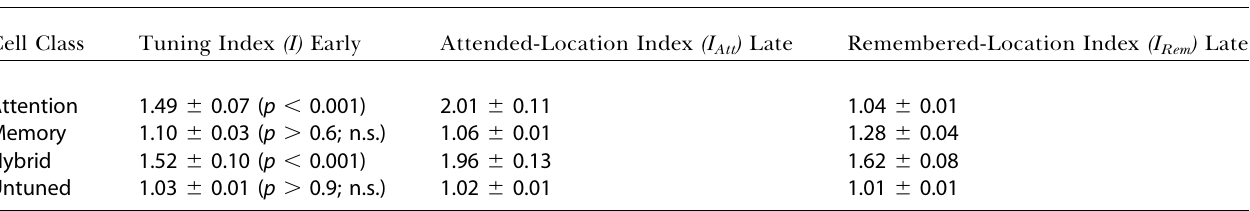
Table 3. Spatial Tuning Indexes Early Versus Late in the